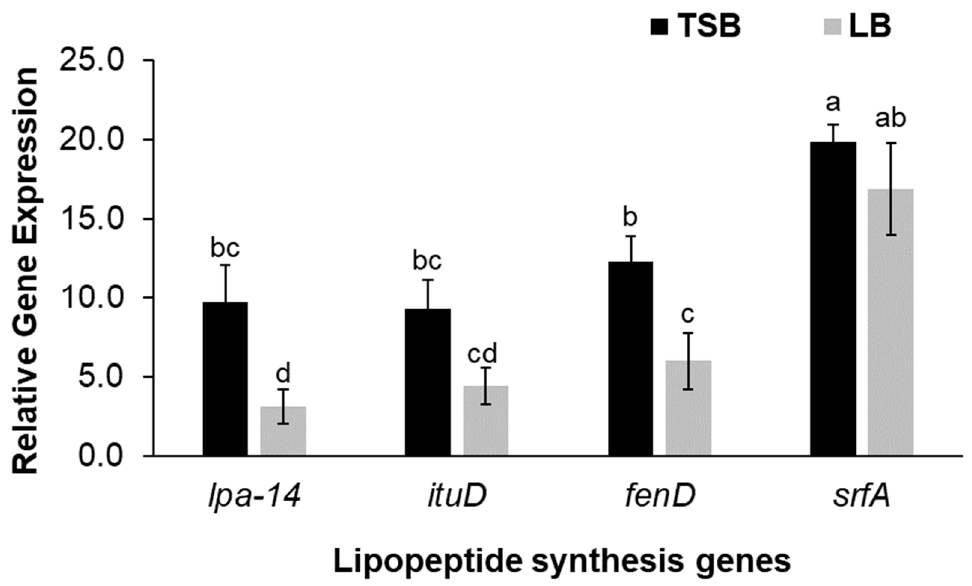
Figure 4. Relative expression of lpa-14a, ituD, fenD , and srfA genes after growth for five days in TSB and LB media. qRT-PCR analysis was performed using primers specific to lpa-14, ituD, fenD and srfA genes, and the expression levels were normalized against 16s rRNA gene levels. The relative mRNA levels of genes were determined by normalization of the value of Ct of the studied genes to the mean value of Ct of reference genes (16s rRNA) by means of analysis of the value 2 −∆ Ct . The values followed by different letters in a column were significantly different at p < 0.05 by Duncan’s multiple range test.